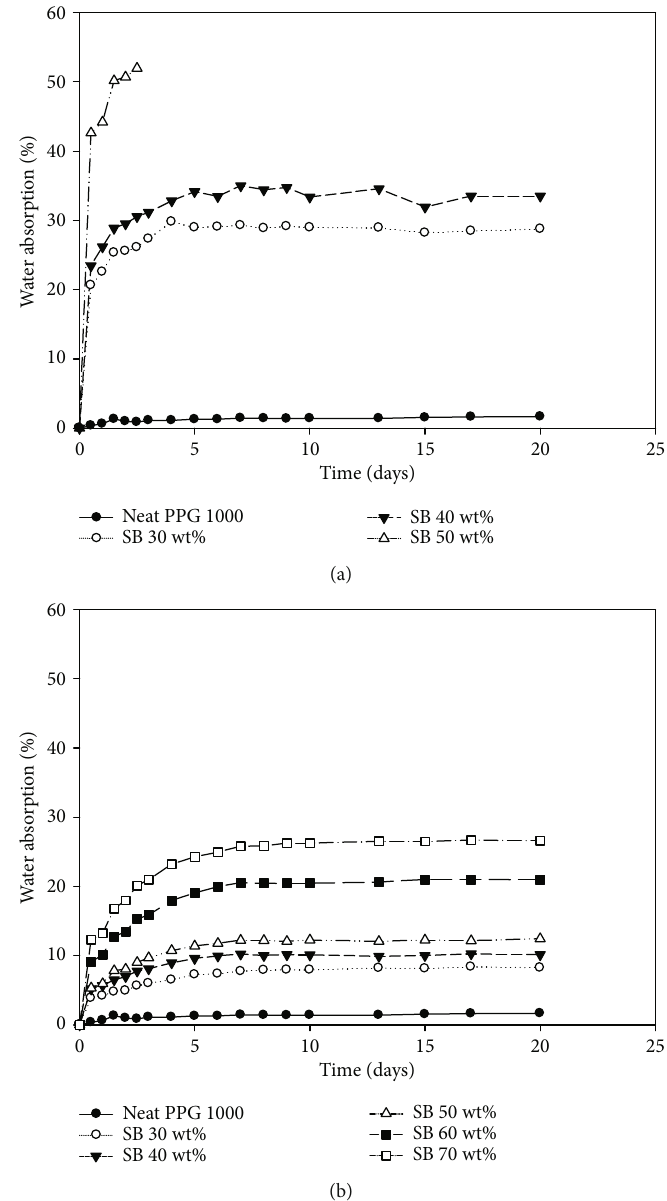
Figure 10: Water absorption property of PPG 1000 PU-EP elastomers: (a) untreated bioadditive IPN and (b) GPS-treated bioadditive